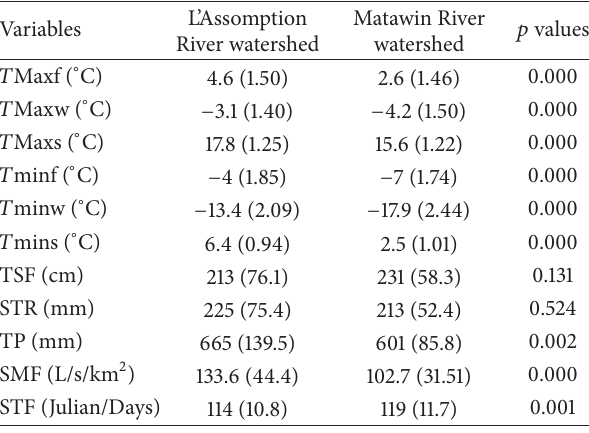
Table1:Comparisonofmeanvaluesofhydroclimatevariablesinthe L’Assomption River and Matawin River watersheds using Student’s 𝑡 -test.